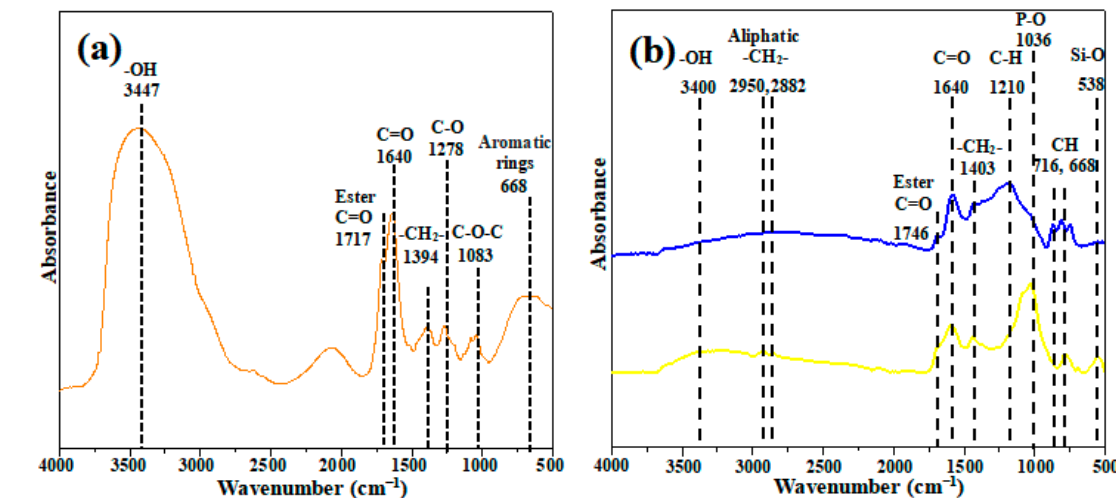
Figure 3. The FTIR spectra of the wood vinegar (WV) ( a ) and biochar (BC, ABC) ( b ). Both BC and ABC have two distinct characteristic peaks at the sum of 2 θ , correspond- ing to the microcrystalline structure of cellulose and hemicellulose [29], respectively (Fig- ure S1). In comparison, the characteristic peak of calcium pyrophosphate (Ca 2 P 2 O 7 ) in ABC